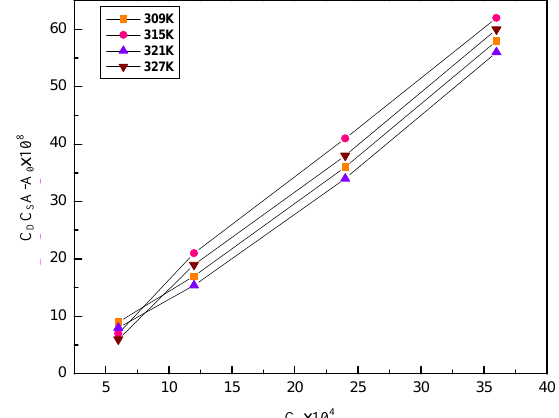
Figure 18. Plots of C